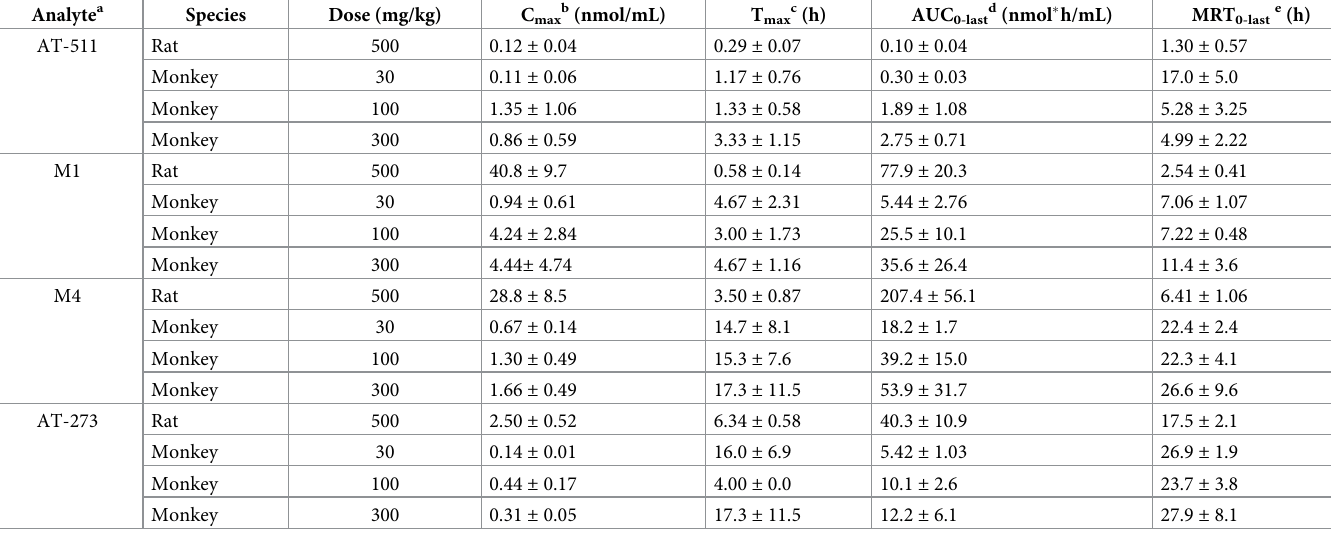
Table 8. Rat and monkey pharmacokinetic parameters following administration of a single oral dose of AT-527. Analyte a